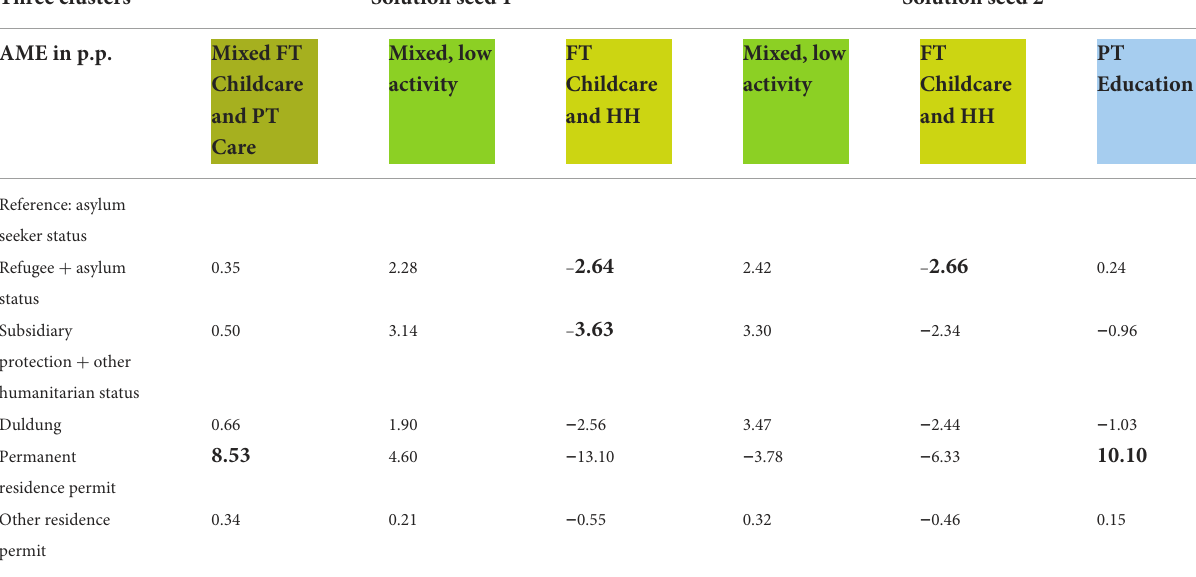
TABLE 5 Pooled analyses: the role of refugees’ legal status. Three clusters Solution seed 1 Solution seed 2 AME in p.p. Mixed FT